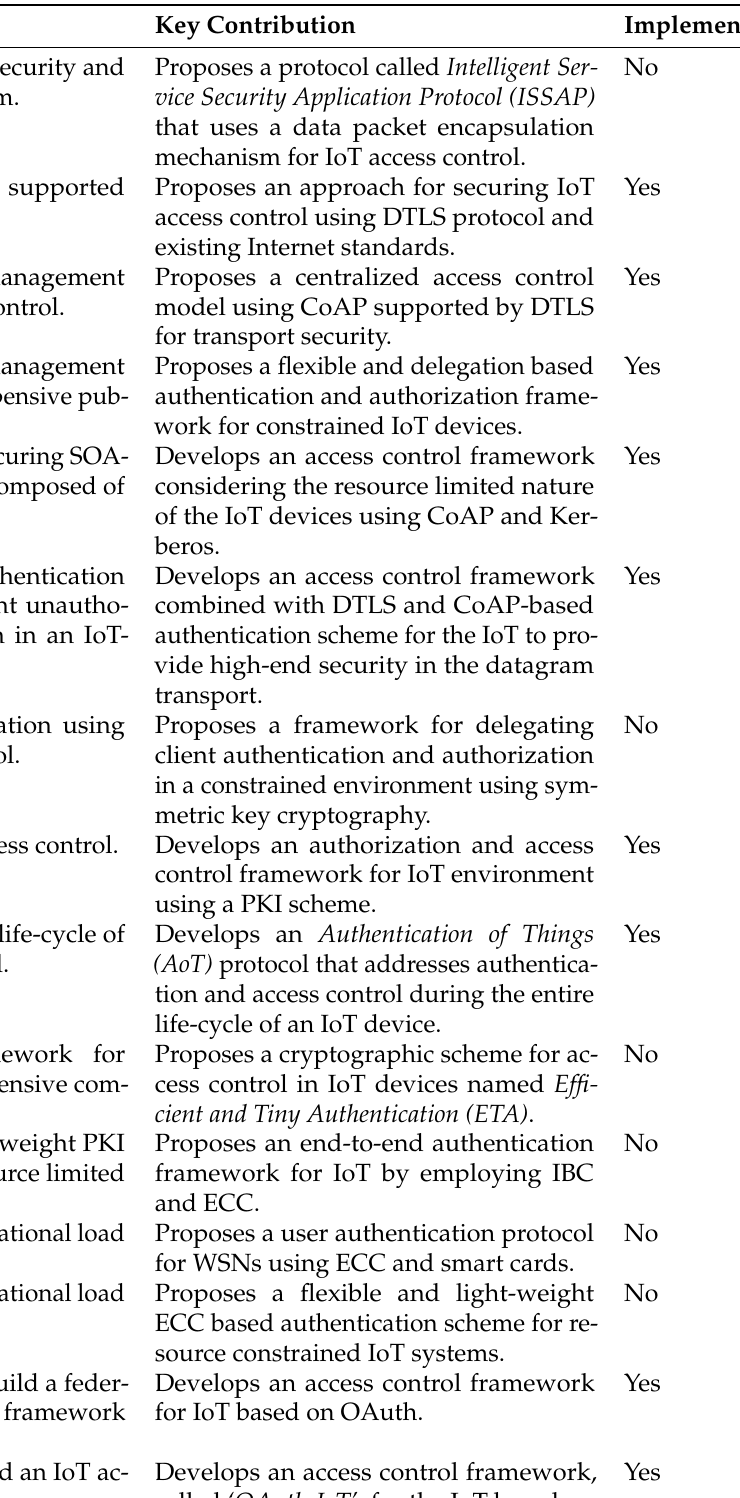
Table 2. Summary of Access Control Mechanisms for the IoT based on